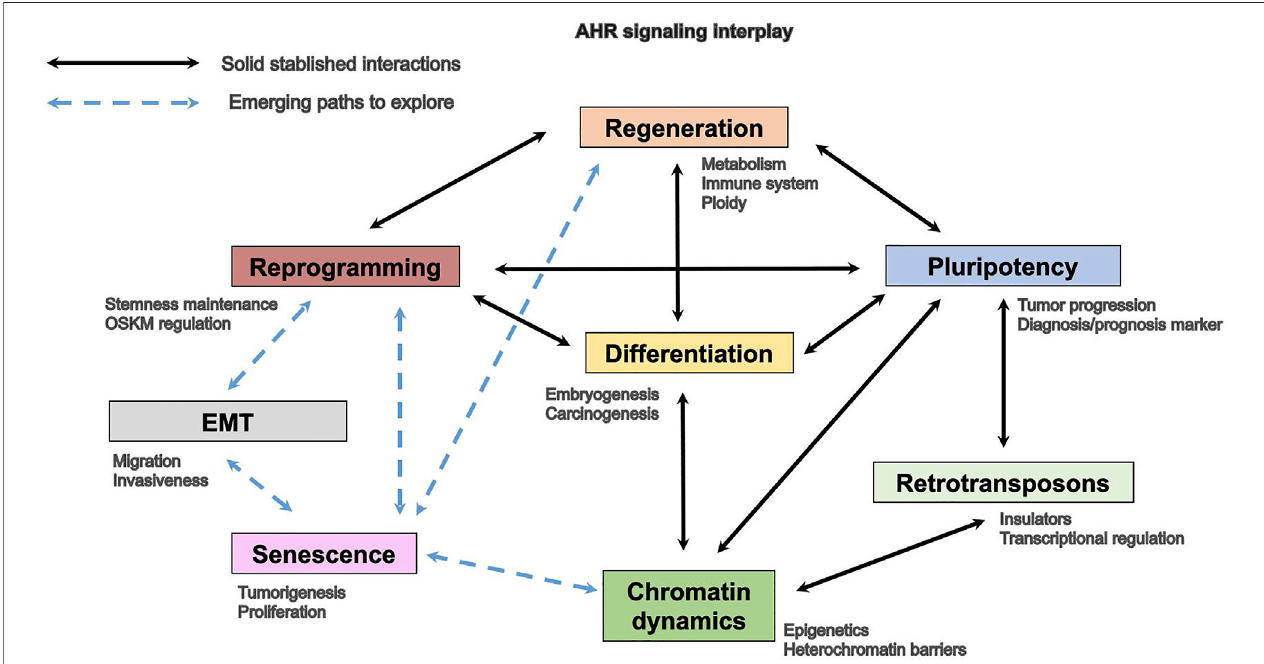
FIGURE 2 | AHR involvement in homeostatic and cancer